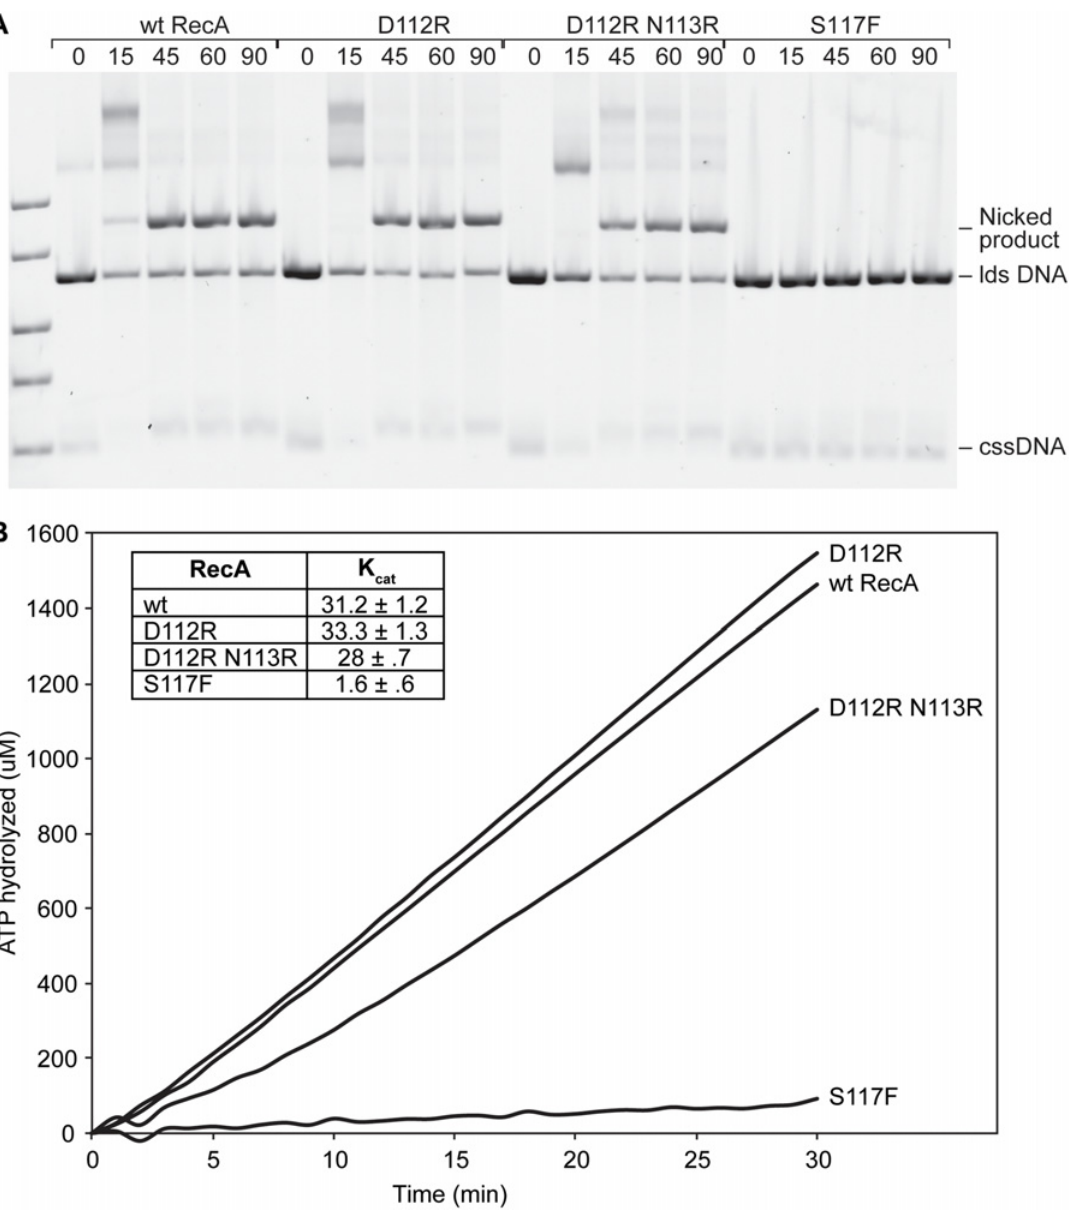
Fig 3. RecA D112R and RecA D112R N113R are capable of strand exchange and ATP hydrolysis. (A) Reactions were carried out as described in Methods. The reaction solutions contained 10 μ M M13mp18 cssDNA, 3.5 μ M RecA, 20 μ M M13mp18 ldsDNA, 3 mM ATP, and 1 μ M SSB in standard RecA buffer. RecA forms filaments on cssDNA, catalyzes pairing with the homologous ldsDNA, and upon completion of strand exchange a nicked circular product is formed. At least four repeats with the wt RecA, D112R, D112R N113R proteins were conducted. Two of these repeats also included trials with the RecA S117F protein, and a representative gel is shown. (B) The RecA-catalyzed ATP hydrolysis in the presence of cssDNA was monitored over time. The reactions were performed as described in Methods. The RecA D112R and D112R N113R exhibit normal ATPase rates, while the S117F minimally hydrolyzes ATP. Time zero corresponds to the time of ATP/SSB